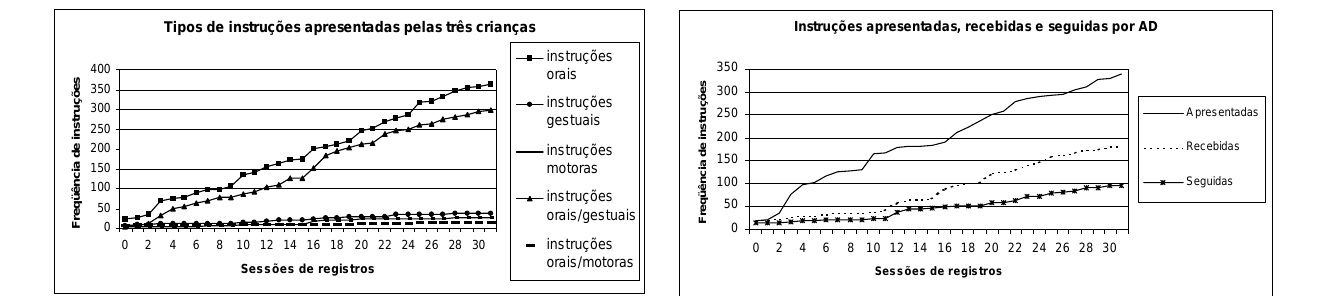
Figura 4 . Freqüência acumulada de instruções apresentadas, recebidas e seguidas por AD no período de Levantamento de Repertório de Entrada (sessão 0) e ao longo das 31 sessões de coleta de dados.